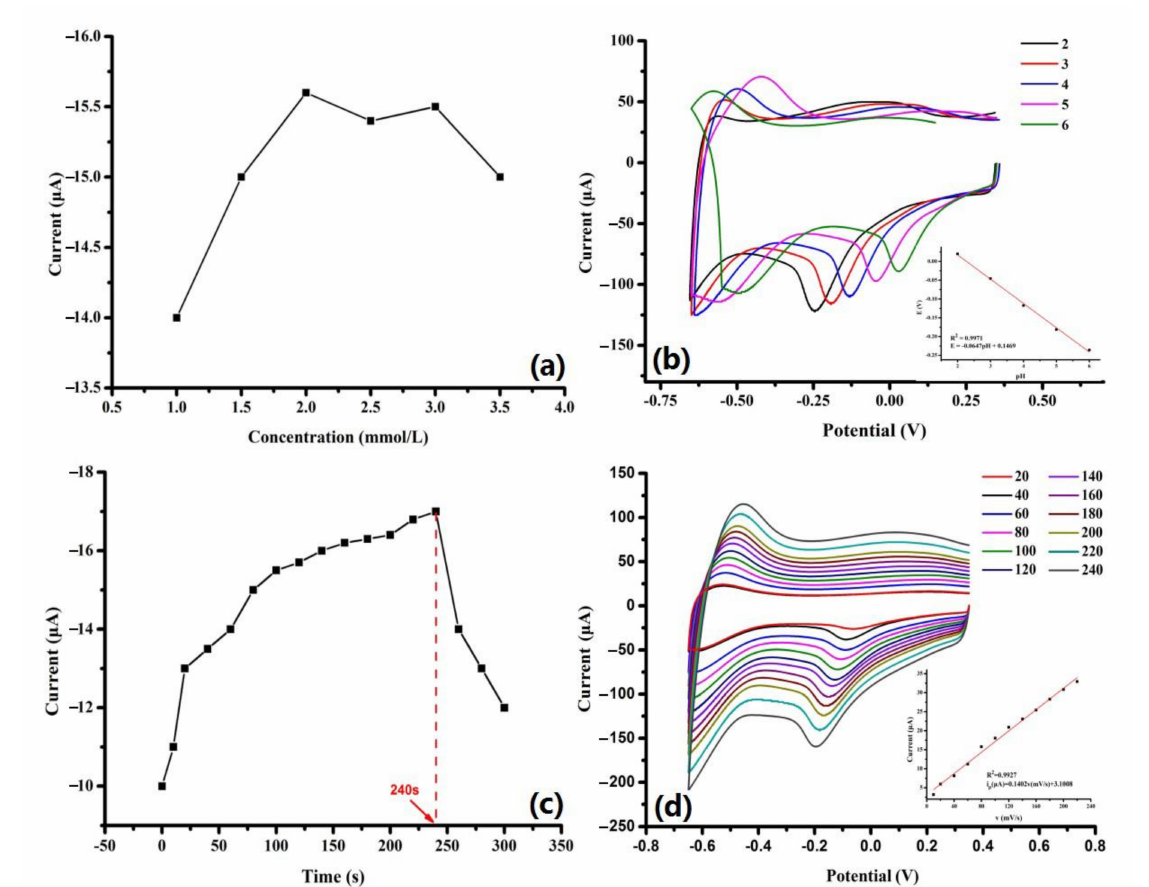
Figure 4. Effect of modifier concentration based on the CV in 100 µ mol/L of lactic acid (pH 4.0) at 100 mVs − 1 from − 0.65 to 0.35 V ( a ), pH value of electrolytic solution based on the electroreduction of lactic acid (0.1 mmol/L) tested by various pH values (ranging from 2 to 6) at 100 mV/s ( b ), accumulation time from 0 to 300 s on the electrochemical response of 50 µ mol/L lactic acid ( c ) and the CV curves recorded in PBS (pH 4.0) containing 100 µ mol/L lactic acid at various scan rates from 20 to 240 mV/s ( d